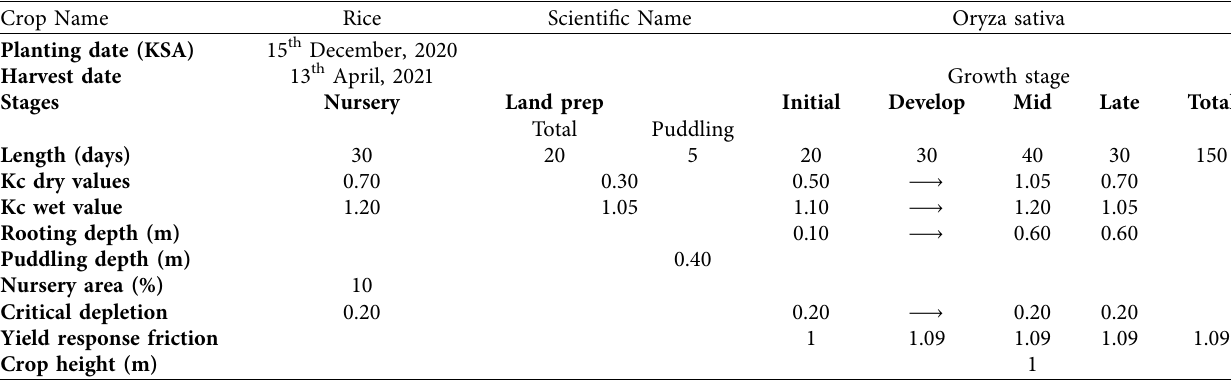
Table 7: Rice crop data at various stages.